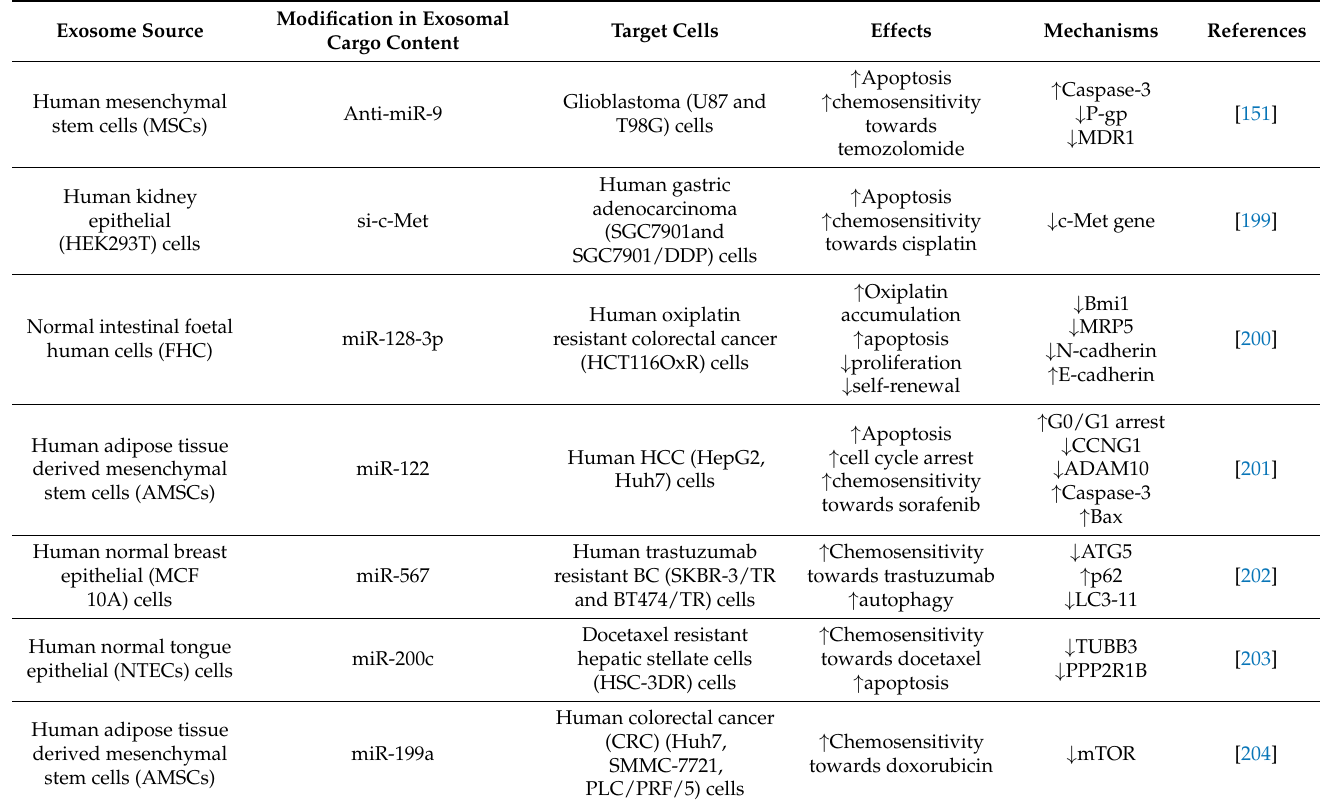
Table 4. Reversal of chemoresistance in resistant cancer cells with exosomal